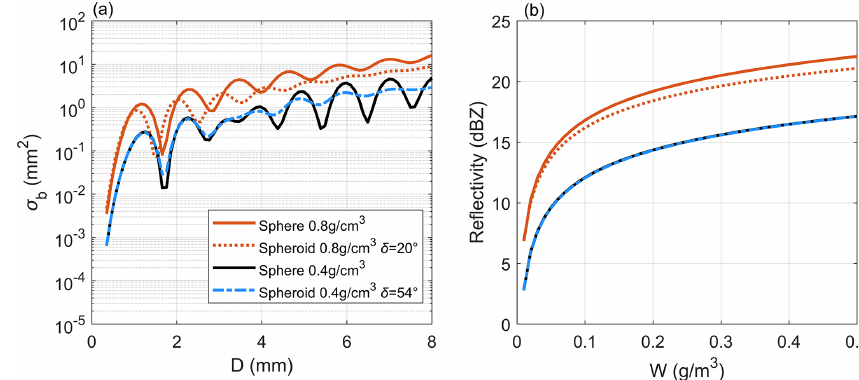
Figure 7. Comparison of the backscattering cross section and corresponding radar reflectivity for graupel between spheres and spheroids at different densities and orientations. (a) Backscattering cross section at a density of 0.4 and 0.8gcm − 3 with δ (SD of canting angle) calculated from Eq. (14). After calculation, δ was 54 ◦ at a density of 0.4gcm − 3 , while δ was 20 ◦ at a density of 0.8gcm − 3 . (b) Radar reflectivity for particles in (a) , where the PSD was assumed to be an exponential distribution with N 0 of 4 × 10 3 m − 3 mm − 1 . Overestimation caused by the spherical assumption increased with an increase in density and decrease in δ